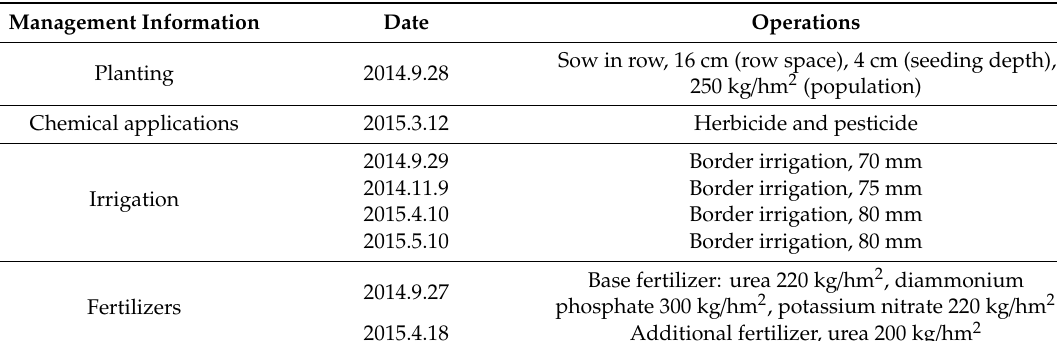
Table 3. Experimental management